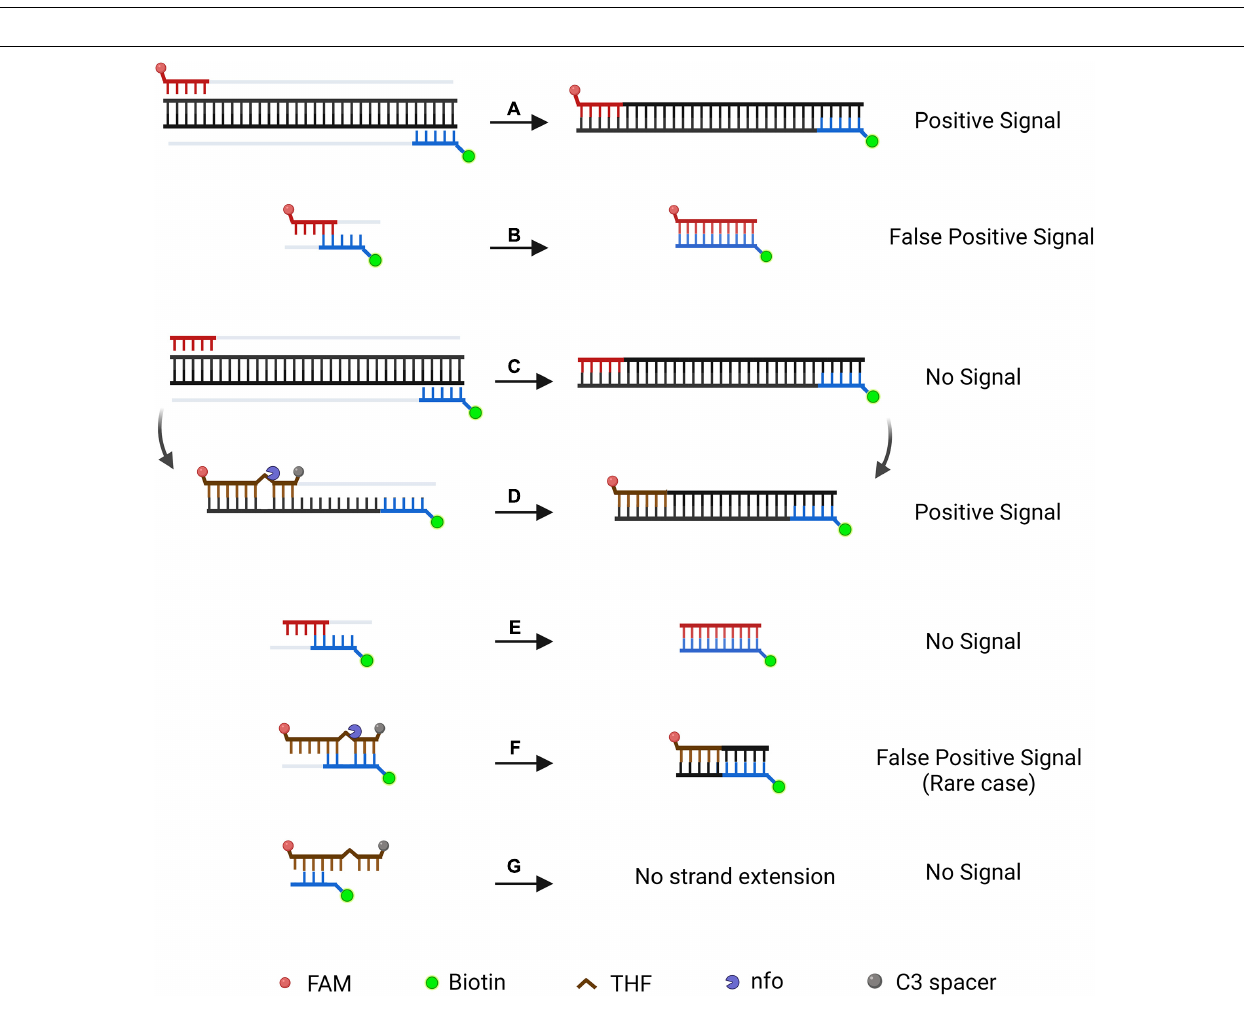
FIGURE 8 | Schematic illustration of a specially designed probe that reduces false-positive signals from primer-dependent artifacts. In the RPA-Basic-based LFD reaction, both the amplification products (A) and the primer–dimers (B) can give positive signals. By using a probe in RPA reaction, amplification of the target DNA from the primers does not yield a positive signal (C) . The amplification product is subjected to another round of amplification under the guidance of the probe and shows a positive signal (D) . Primer dimers in the probe-based RPA reaction give no positive signal (E) . In most cases, the primer–probe complex will not give a positive signal (G) . The complex gives a positive signal when the primer and probe pairing multiple bases flanking the THF site (F) . DNA strands are represented by horizontal lines, and matching bases are represented by short vertical lines between the DNA strands. The expected amplification of the DNA strand is indicated by the gray line. Modification group and nfo are represented by different colors and forms, and a legend is given at the bottom of the figure. Created with BioRender.com. Picture inspired by Wu et al. (2020).